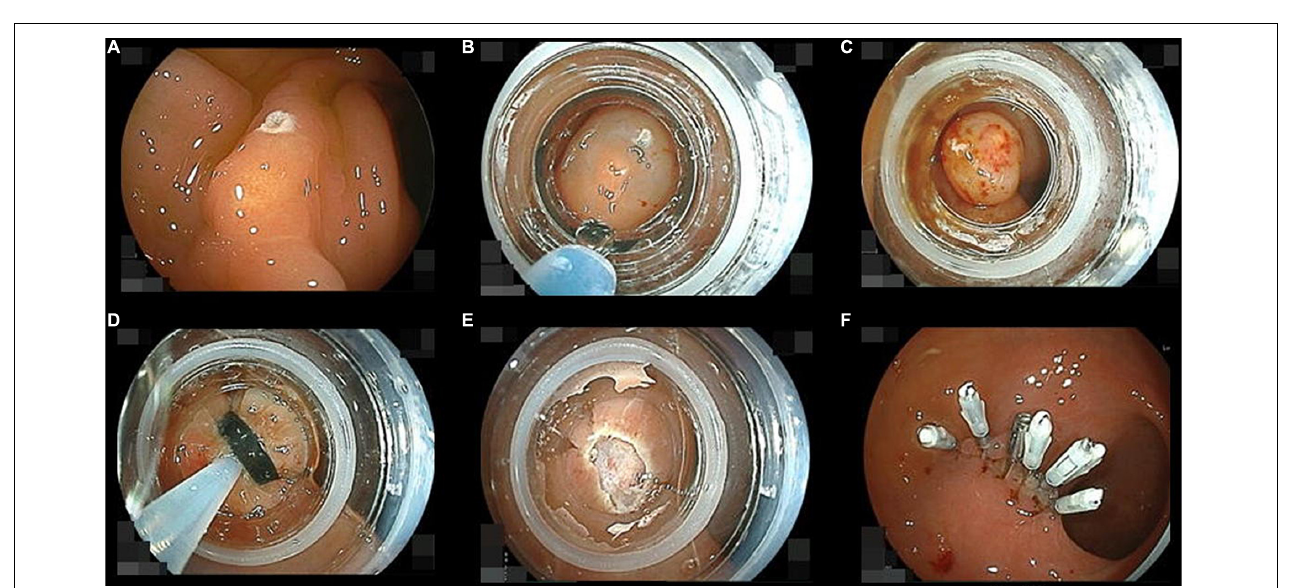
FIGURE 2 | Pictures of the underwater endoscopic mucosal resection sequence. (A) Filling up the rectum with distilled water while completely aspirating residual gas. (B) Snaring the neuroendocrine tumor (NET) involving the surrounding mucosa and the submucosa under the NET. If they cannot be appropriately snared, snaring should be repeated until it is achieved. (C) When the specimen was resected, we confirm there are neither any residual tumor nor perforations under water immersion. (D) The wound was closed with endoclips during water immersion.